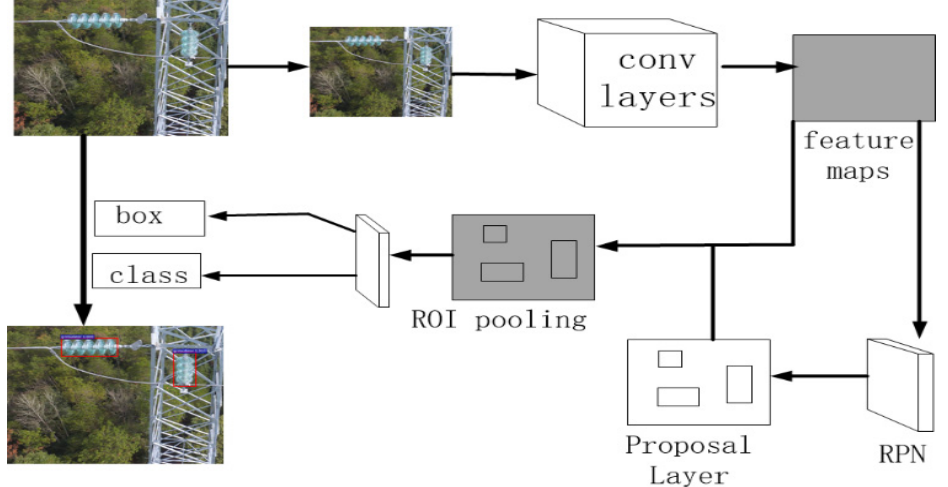
Figure 2. Insulator recognition based on Faster RCNN.